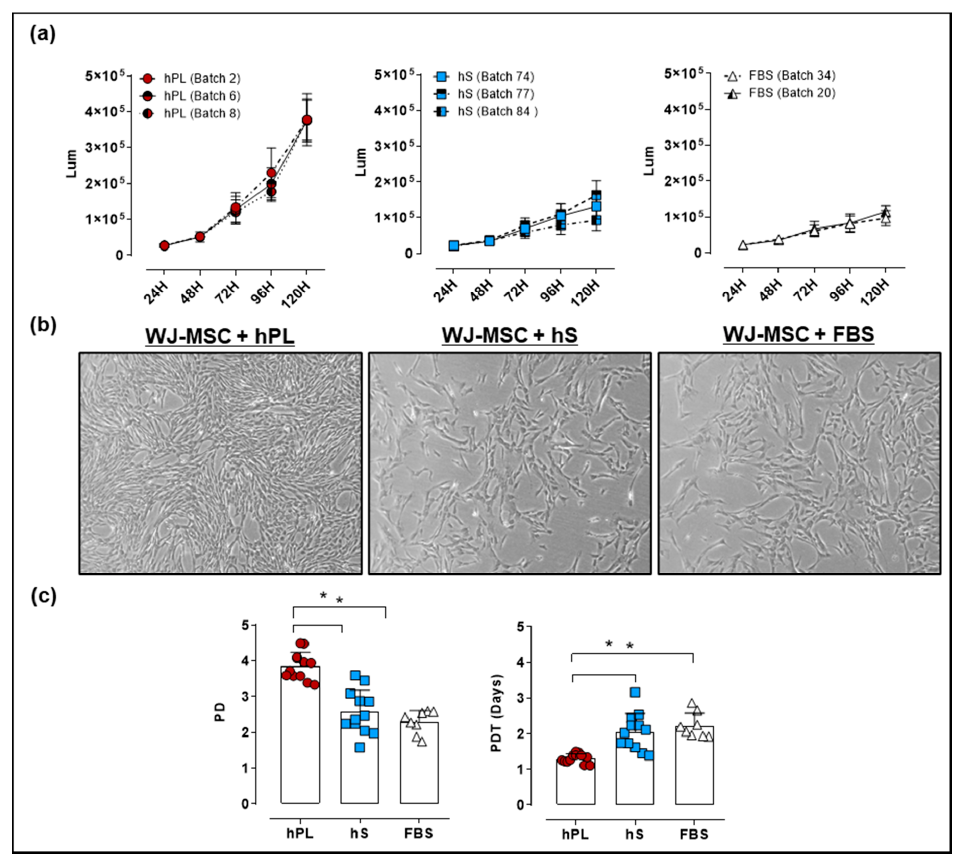
Figure 4. Evaluation of Wharton’s jelly (WJ)-mesenchymal stromal cell (MSC) growth expanded with 10% hPL, hS and FBS. ( a ) Proliferation Kinetics and viability of WJ-MSC expanded with different batches of hPL, hS and FBS determined by CellTiter-Glo Luminescent Cell Viability Assay (measurement units in Lum); ( b ) Representative micrographies of WJ-MSC showing cells in passage 2 expanded in hPL, hS and FBS after 4 days of culture (magnification 50X); ( c ) Population doubling (PD) and population doubling time (PDT) of WJ-MSC seeded with 10% hPL (green, n = 4 batches), hS (blue, n = 3 batches) and FBS (red, n = 2 batches). Data is represented as mean ± SD, * p < 0.05, analyzed by Tukey’s